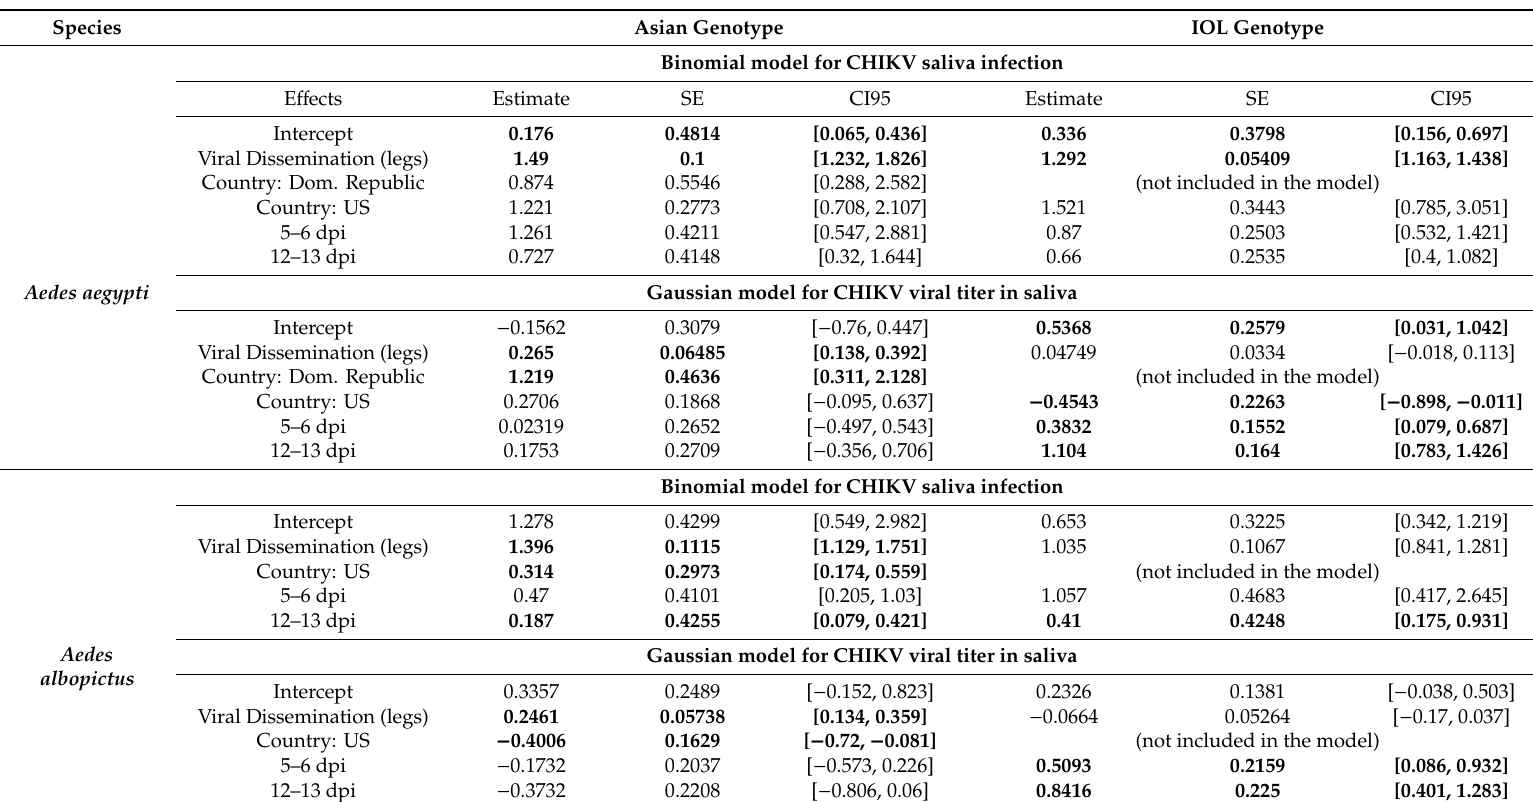
Table 2. Estimated e ff ects and 95% confidence interval of viral dissemination, country of origin, and days post-infection for the Asian and IOL CHIKV genotypes for both Ae. aegypti and Ae. albopictus , as measured by in the binomial and Gaussian generalized linear